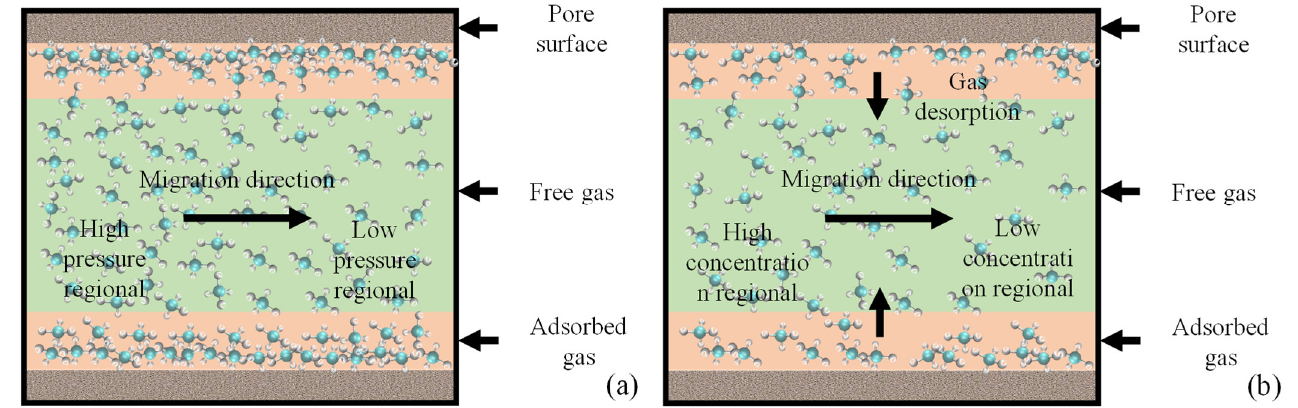
Figure 9. Shale gas production process ( a ) early and ( b ) late methane distribution and migration process diagram. Free gas first migrates from the high-pressure zone to the low-pressure zone under the action of the pressure gradient. When the pore pressure is lower than the critical desorption pressure, the adsorbed gas gradually desorbs and diffuses from the high-concentration region to the low-concentration region through the seepage channel.